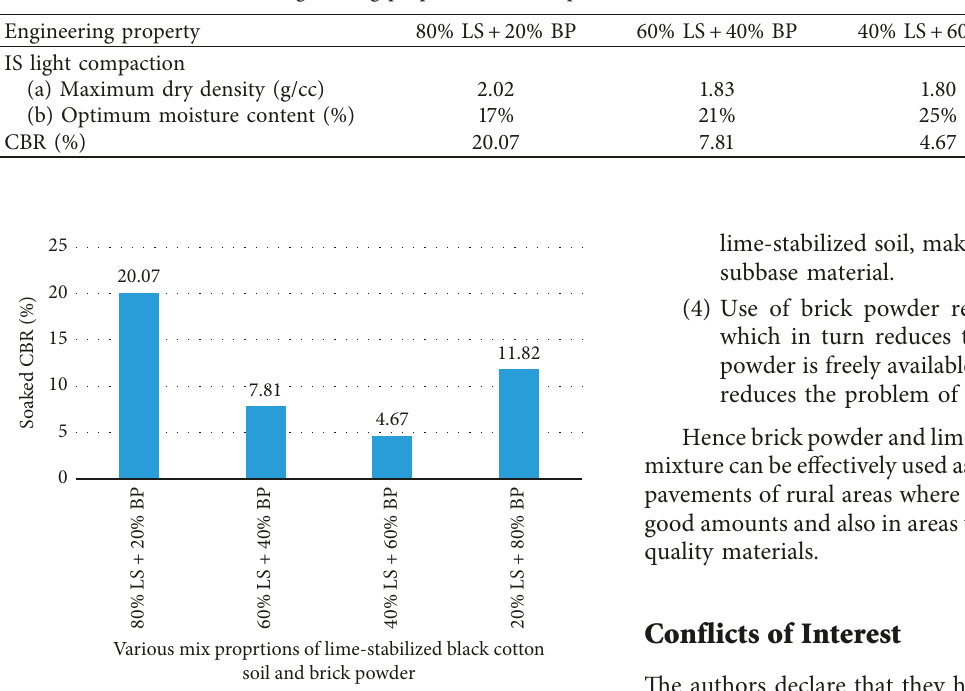
Figure 5: Variation of soaked CBR for different mix proportions of lime-stabilized black cotton soil and brick